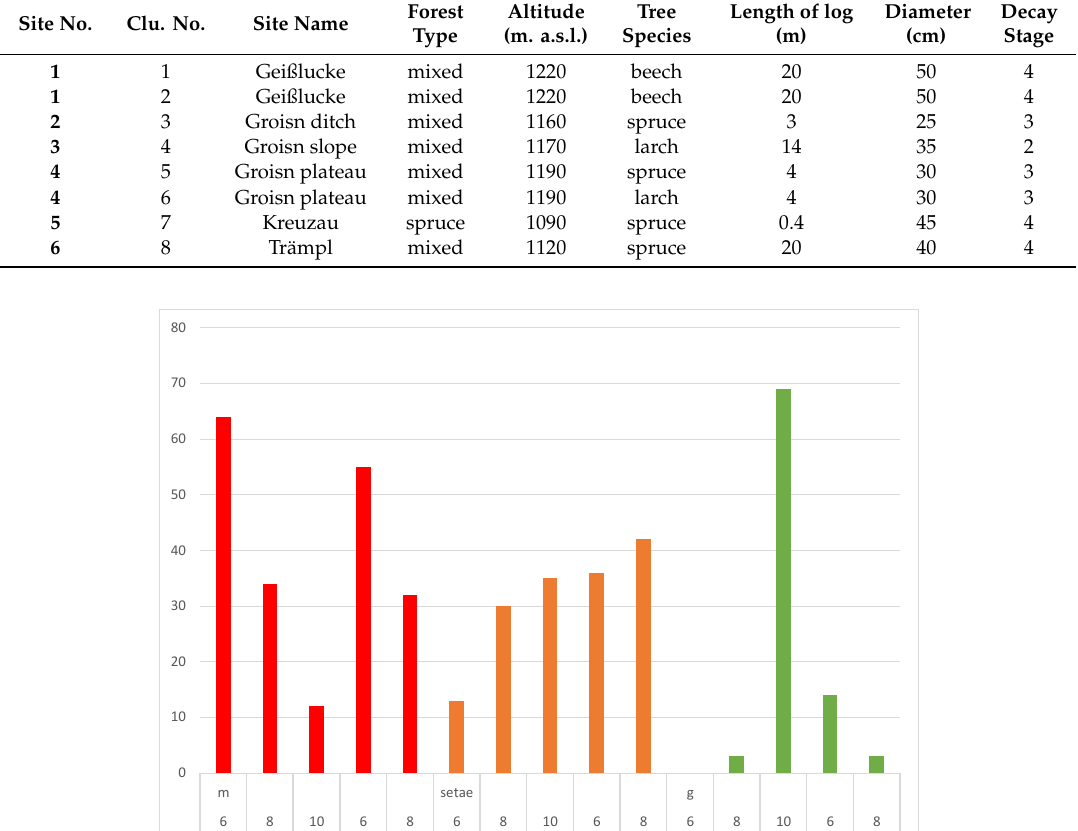
Table 1. Investigated sites at the Kalkalpen National Park, Austria; Clu. No.—number of the cluster of sporophytes; decay stage following Lachat, et al. [32]. Site No.